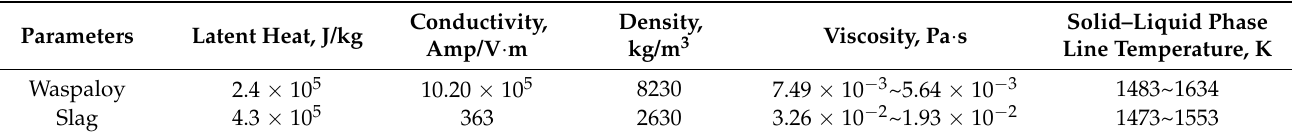
Table 1. Physical parameters of slag and